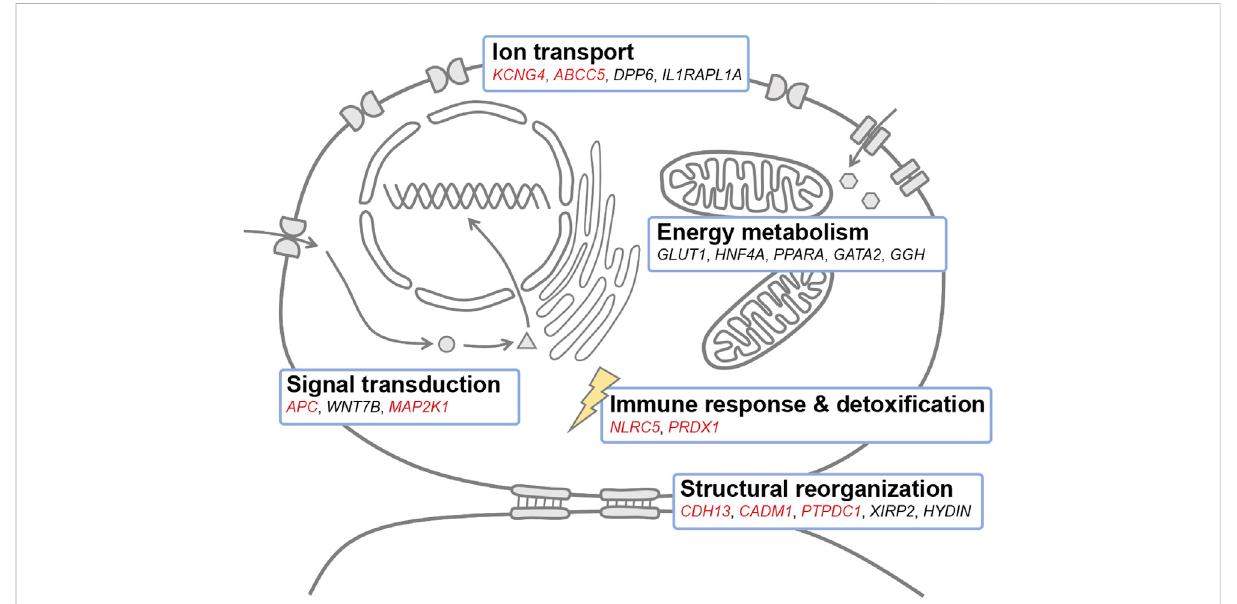
FIGURE 4 Candidate genes associated with adaptation to salinity change in Triplophysa loaches. Genes marked in red were associated with adaptation to salinity changes in both T. stewarti and T. stenura . Genes marked in black were identi fi ed in T. stewarti . The schematic model in which genes are assignedtodifferentfunctionalcategorieswasadaptedfromNguyenetal.(2016). KCNG4 :potassiumvoltage-gatedchannelsubfamilyGmember4, ABCC5 : C member 5 multi-speci fi c organic anion transporter 5, DPP6 : dipeptidyl aminopeptidase-like protein 6, IL1RAPL1A : interleukin-1 receptor accessory protein-like 1-A, GLUT1 : facilitated glucose transporter member 1, HNF4A : hepatocyte nuclear factor 4-alpha, PPARA : peroxisomeproliferator-activatedreceptoralpha, GATA2 :GATA-bindingfactor2, GGH :gamma-glutamylhydrolase, NLRC5 :NOD-likereceptorC5, PRDX1 :peroxiredoxin-1, CDH13 :cadherin-13, CADM1 :cell adhesionmolecule 1, PTPDC1 :proteintyrosine phosphatasedomain-containing protein 1, XIRP2 : Xin actin-binding repeat-containing protein 2, HYDIN : hydrocephalus-inducing protein-like protein, APC : adenomatous polyposis coli protein, MAP2K1 : dual speci fi city mitogen-activated protein kinase